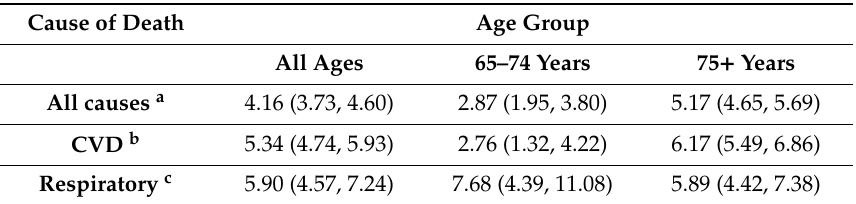
Table 3. Percent increase in mortality and associated 95 % confidence interval per 1 ◦ C increase in maximum temperature (average of lags 0–3) above the turning point (31.5 ◦ C), by cause of death and age group in the Greater Athens